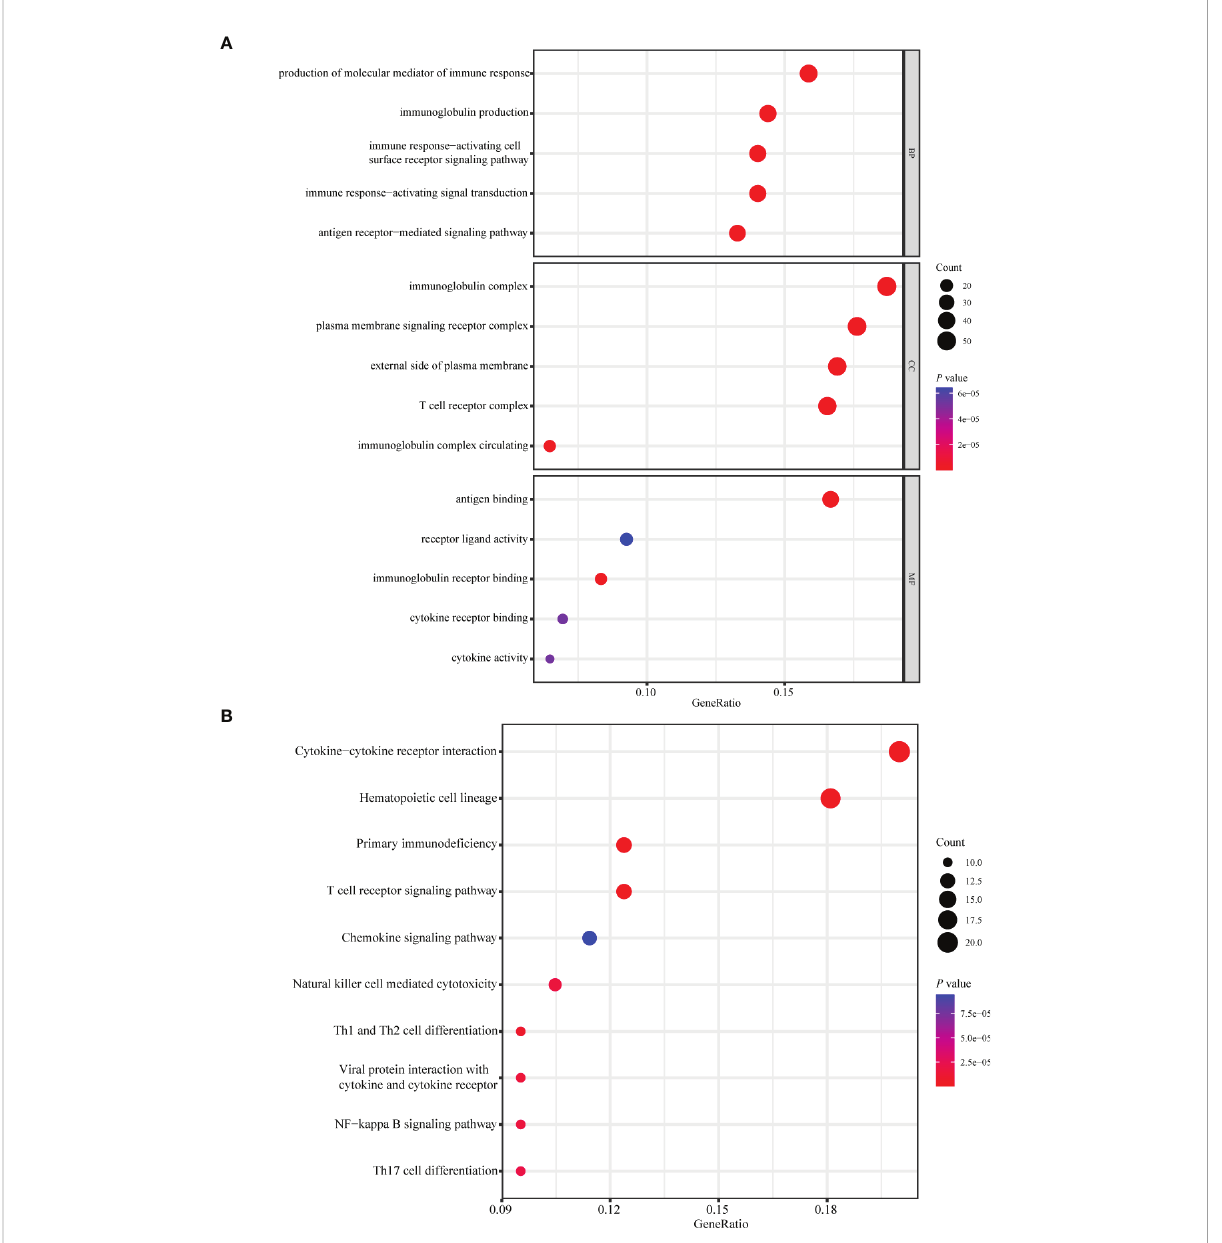
FIGURE 5 Enrichment analysis of differentially expressed genes between the high- and low-risk group. Bubble plot of (A) GO and (B) KEGG pathway analysis of genes expressed differentially between the high- and low-risk group. GO, Gene Ontology; KEGG, Kyoto Encyclopedia of Genes and Genomes; BP, biological process; CC, cellular components; MF, molecular